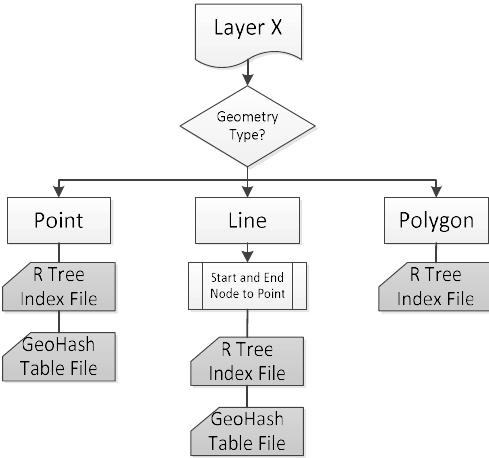
Figure 2. Spatial index for different geometry data